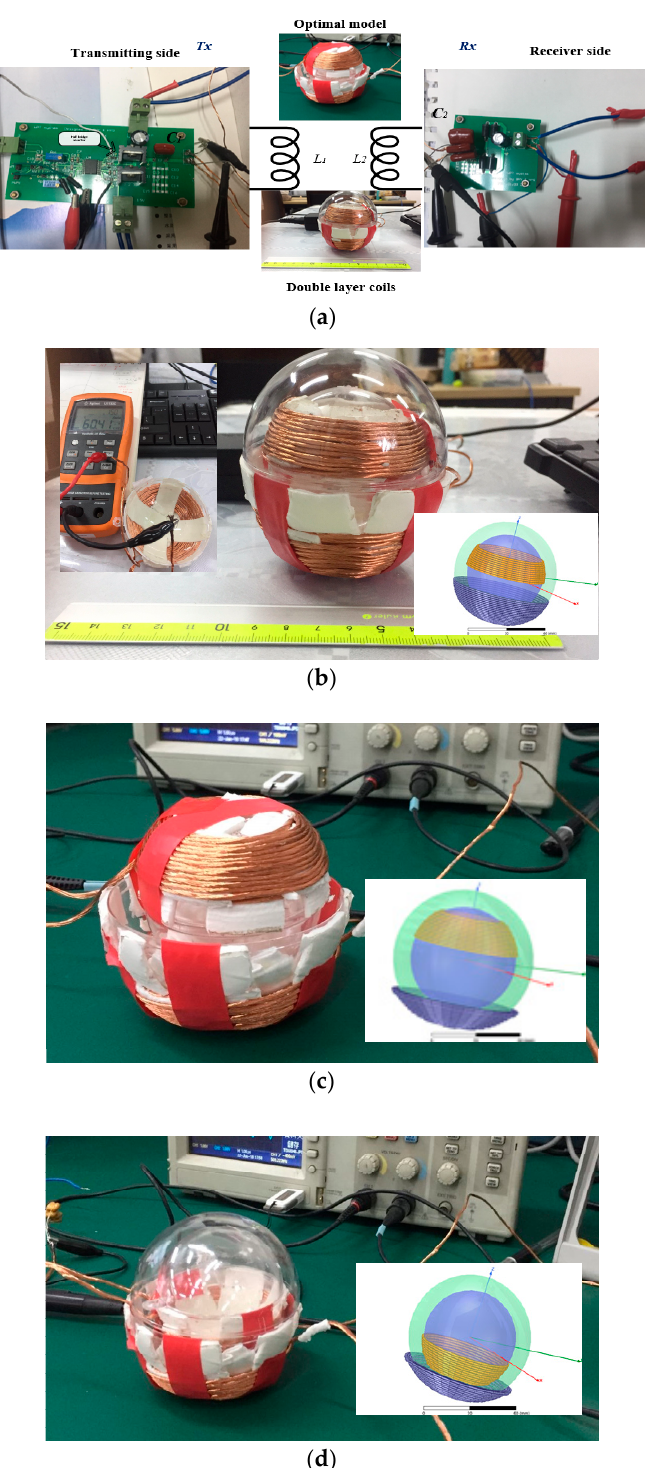
Figure 19. The WPT system: ( a ) SS-compensated WPT; ( b ) double-layer windings; ( c ) optimal model; ( d ) modified hemisphere windings.